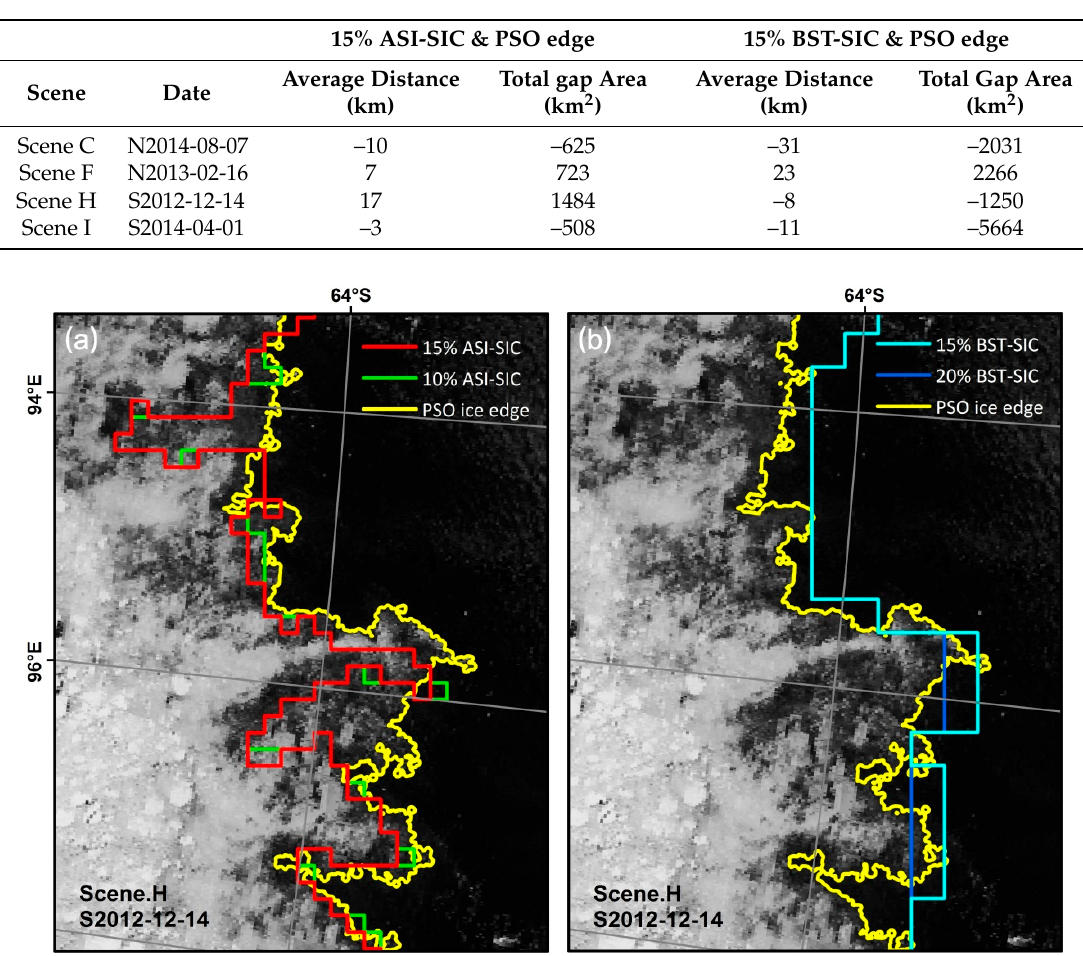
Figure 8. Comparison between contours of the 15% threshold and alternatives with PSO ice edges. ( a ) 15% ASI ‐ SIC and 10% ASI ‐ SIC, ( b ) 15% BST ‐ SIC and 20% BST ‐ SIC overlaid on the MOD09GA, at 14 December 2014, Antarctic.